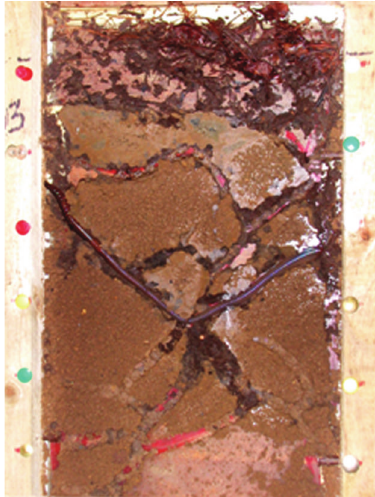
Figure 4: Upper 30 cm showing view through the glass side of an 80cm deep Evans’ box used to examine burrowing behaviour of a single mature L. terrestris (the adult can be seen across the centre).